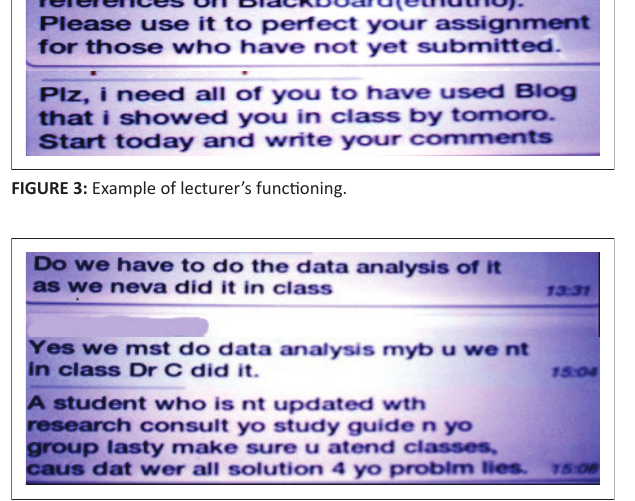
FIGURE 4: Example of students’ sharing of academic